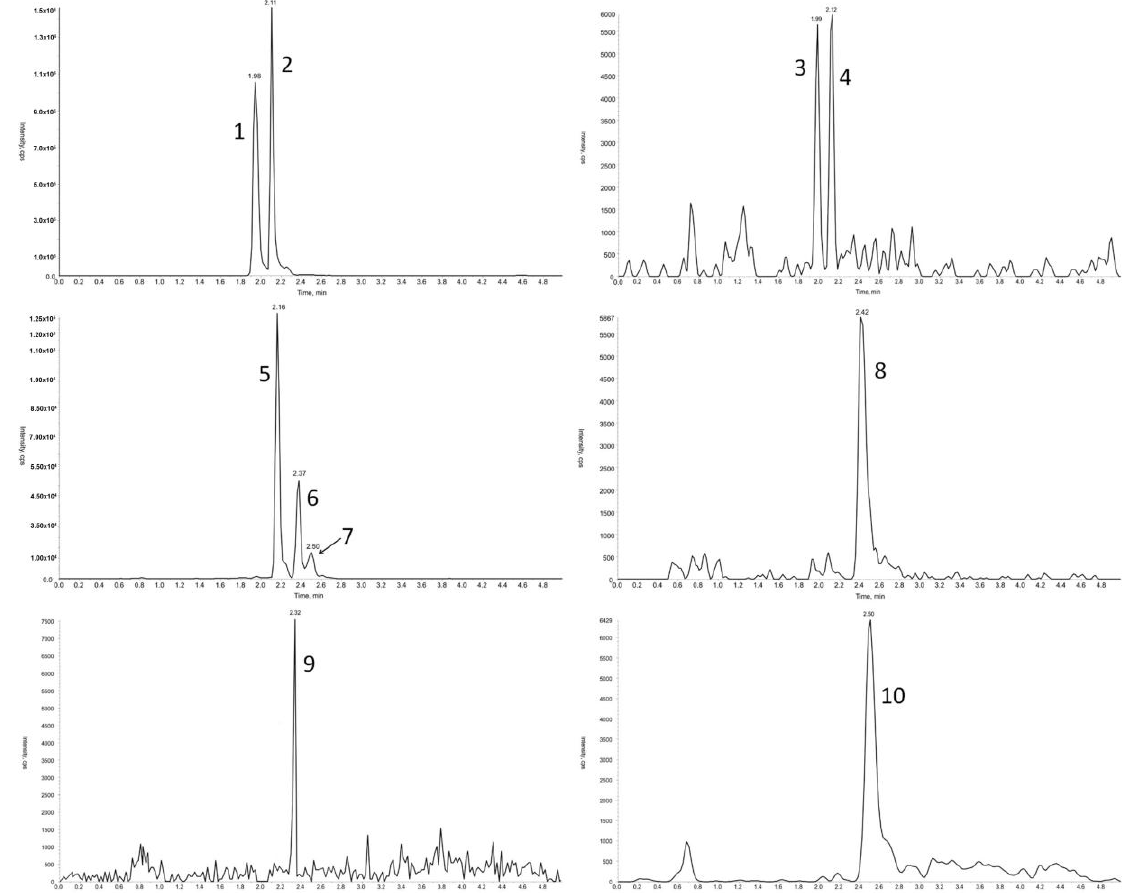
Figure 2. The micro-HPLC-MS/MS chromatograms of betalain compounds identified in the